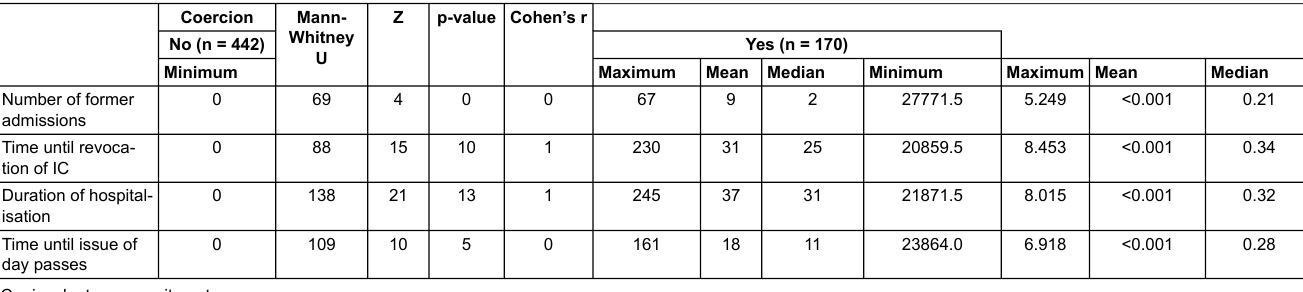
Table 4: Comparison of group with/without coercion of procedural aspects during